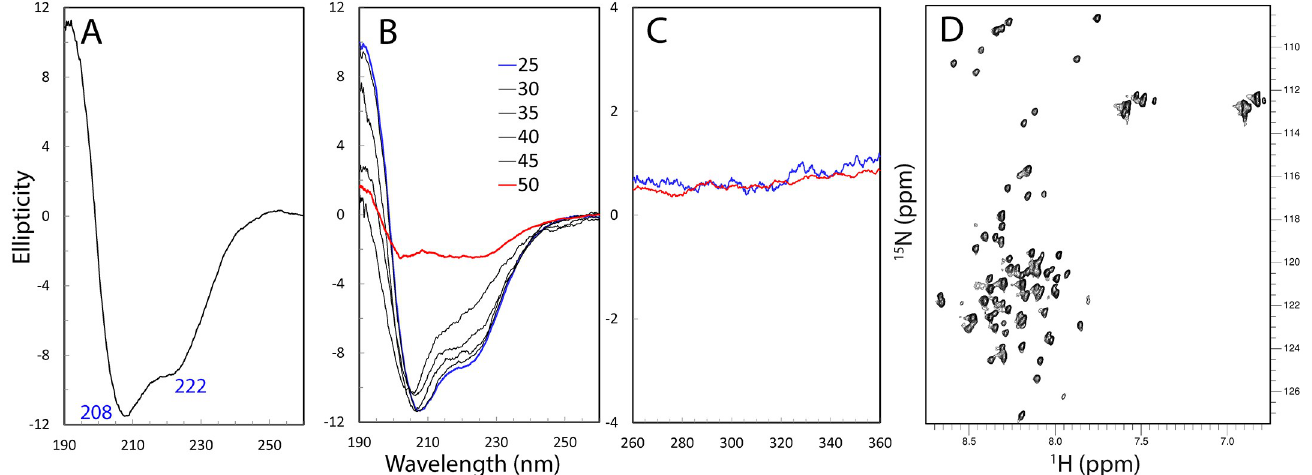
Fig 2. Biophysical characterization of the TMEM106B cytoplasmic domain. (A) Far-UV CD spectrum of the TMEM106B cytoplasmic domain at a protein concentration of 10 μ M at 25 ˚C in 5 mM phosphate buffer (pH 6.5). (B) Far-UV CD spectrum of the TMEM106B cytoplasmic domain at 10 μ M at different temperatures in 5 mM phosphate buffer (pH 6.5). (C) Near-UV CD spectra of the TMEM106B cytoplasmic domain at a protein concentration of 100 μ M at 25 ˚C in the 5 mM phosphate buffer (pH 6.5) in the absence (blue) and in the presence of 8 M urea. (D) Two- dimensional 1H-15N NMR HSQC spectrum of the TMEM106B cytoplasmic domain acquired at 25 ˚C at a concentration of 100 μ M in 5 mM phosphate buffer (pH 6.5).